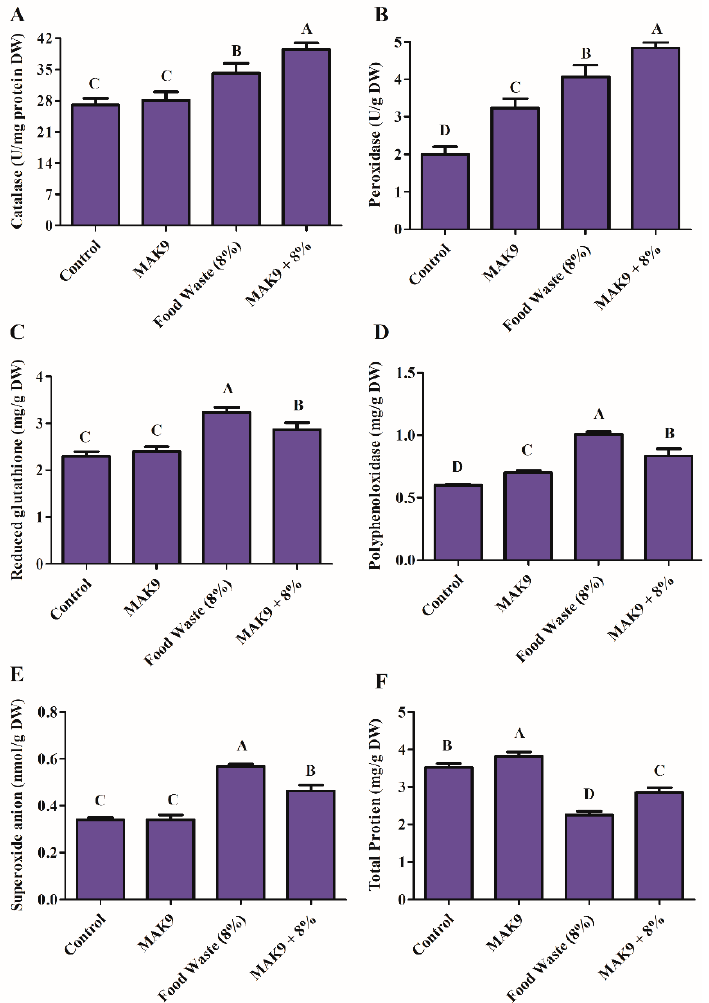
Figure 5. Effects of isolate MAK9 on antioxidant levels in Chinese cabbage with and without food waste (8%) application. ( A ) Catalase, ( B ) peroxidase, ( C ) glutathione, ( D ) polyphenol oxidase, ( E ) superoxide anions, and ( F ) total protein. Different letters indicate differences between the mean values of three replicates ± standard deviations.